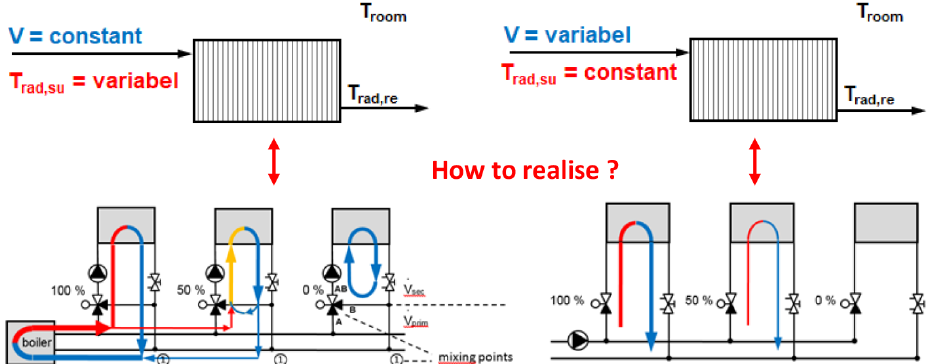
Fig. 18. – In- and outgoing energy flows in a steady state